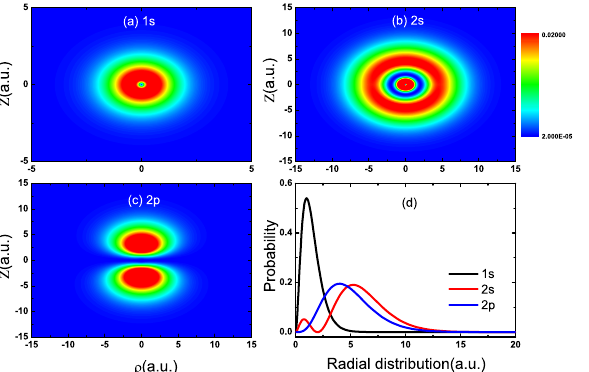
Figure 2. (Color online) Electron wave packet distribution for H(1 s ) state ( a ), H(2 s ) state ( b ) and H(2 p ) state ( c ). Radial distribution of the three electron eigen wave packets ( d